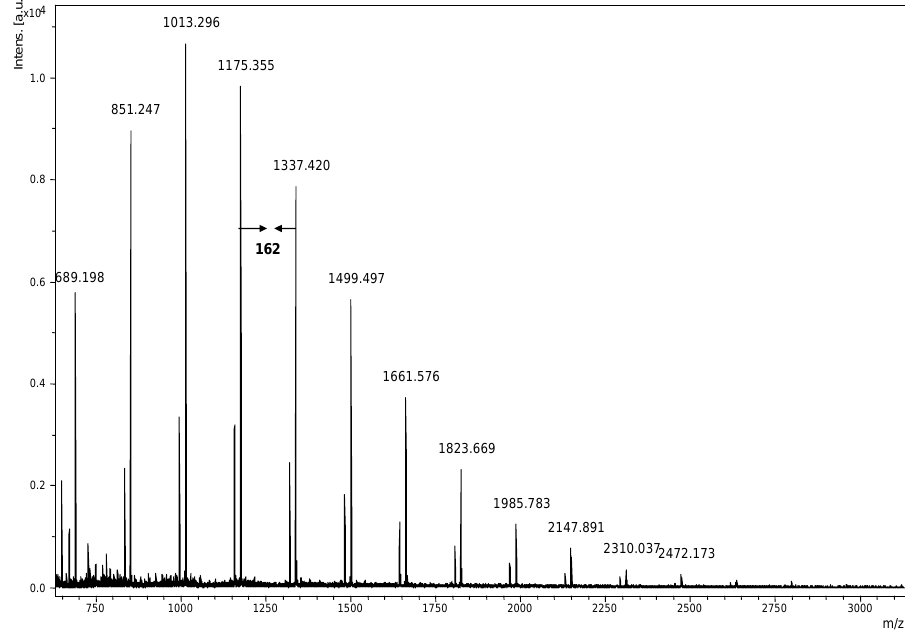
Figure 1. MALDI-TOF mass spectrum of Ganoderma lucidum glucans using 2,5-DHB as matrix. The mass difference of 162.1 Da between neighboring peaks is